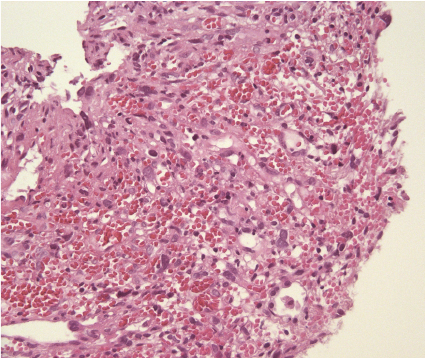
Figure 1: Primary splenic angiosarcoma. Staining with hematoxylin and eosin. 20-fold magnification.